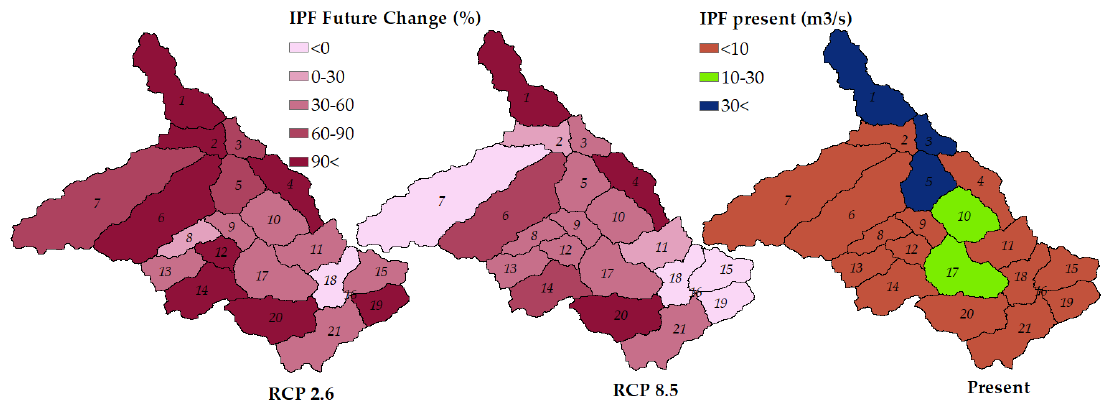
Figure 10. Spatial map of maximum IPF (m 3 s − 1 ) estimation in each subbasin in the present period and the percent change of maximum IPF (m 3 s − 1 ) projection in each subbasin in the near future.